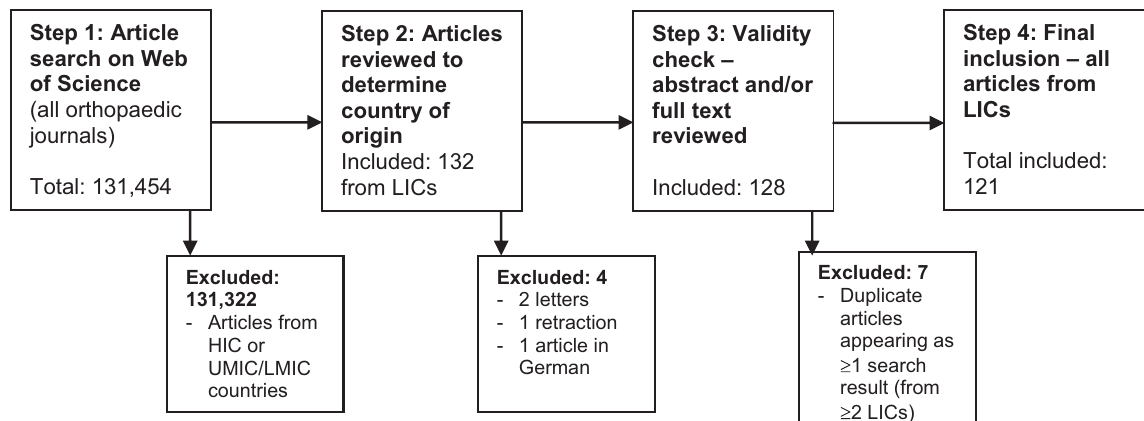
Figure 1. Flow diagram of article-selection process.